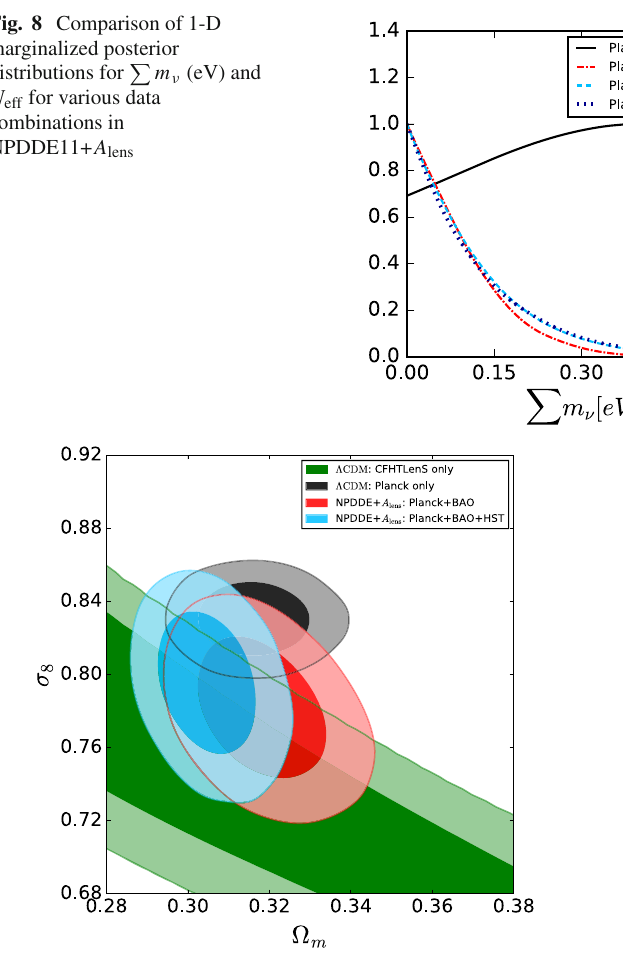
Fig. 9 1 σ and 2 σ marginalized contours in the σ 8 − (cid:6) m plane showing that the NPDDE11+ A lens model is effective in reducing the tension between CFHTLenS and Planck 2015 (cid:2) m ν < 0.107 eV (95%), which is also an get